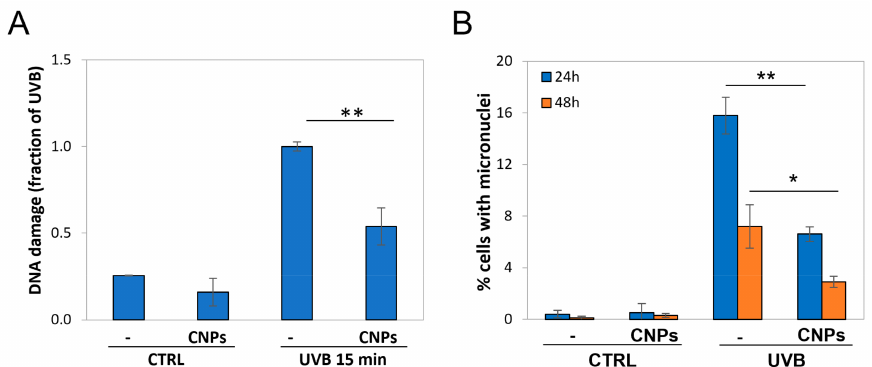
Figure 3. Nanoceria reduced DNA damage and prevented mutagenesis in HaCaT cells. ( A ) Comet assay analysis of UVB-irradiated HaCaT ± nanoceria (CNPs). Values are normalized with respect to the maximum value (UVB 1h) posed = 1. Statistical significance was calculated via Student’s t -test. ** p < 0.01, with respect to UVB-irradiated cells. ( B ) Micronuclei after UVB exposure ± nanoceria (CNPs). Nanoceria pretreatment halves UVB-induced micronuclei. Statistical significance was calculated via Student’s t -test. * p < 0.05 and ** p < 0.001 with respect to UVB-irradiated